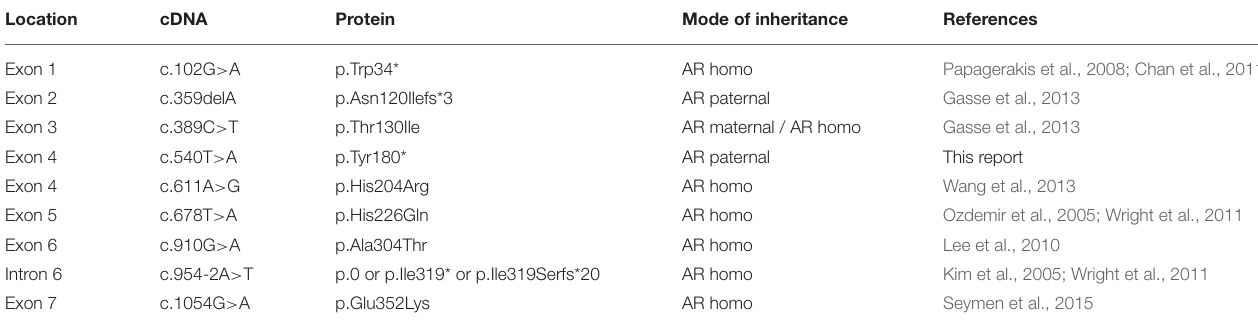
* Sequences based on the reference sequence for mRNA (NM_004771.3) and protein (NP_004762.2), where the A of the ATG translation initiation codon is designated as nucleotide